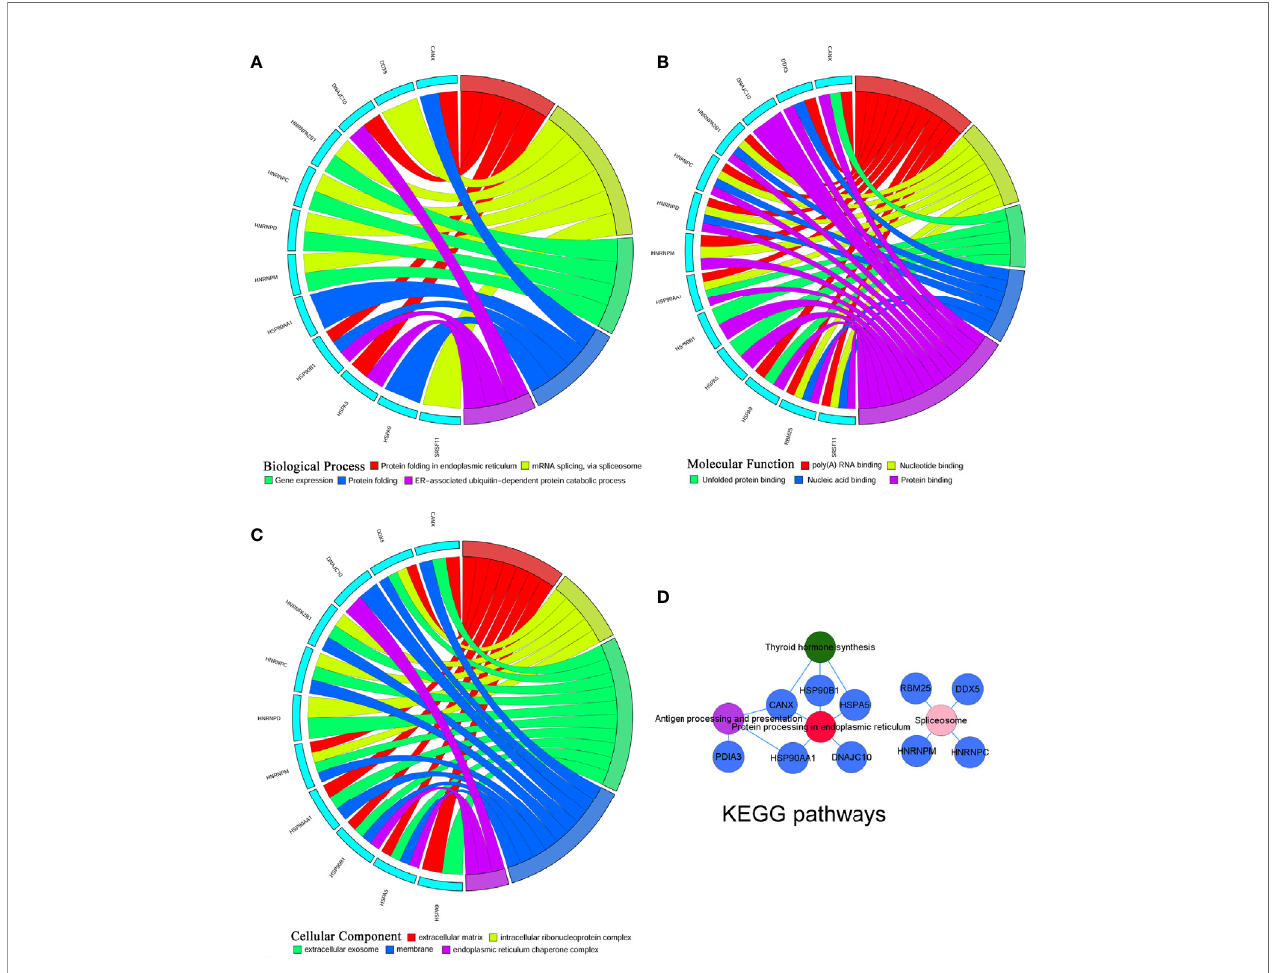
FIGURE 5 | Gene Ontology terms and Kyoto Encyclopedia of Genes and Genomes (KEGG) pathways of the hub differentially expressed genes (DEGs) set. (A) Biological process, (B) Cellular component, (C) Molecular function, (D) KEGG pathways: Colors from red, pink, green to purple indicate that the P values are sorted from minimum to